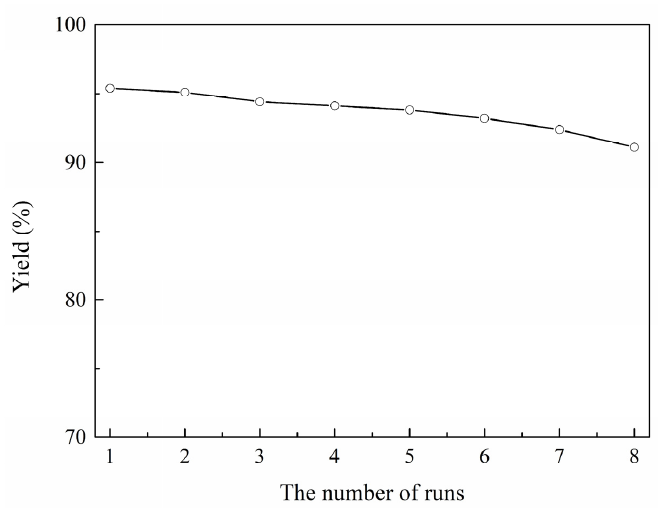
Figure 8. Effect of [HSO 3 ‐ bCPL][HSO 4 ] recycling on the yield. Reaction conditions: temperature = 140 °C, reaction time = 3 h, methanol/oil/IL (molar ratio) = 9/1/0.20.